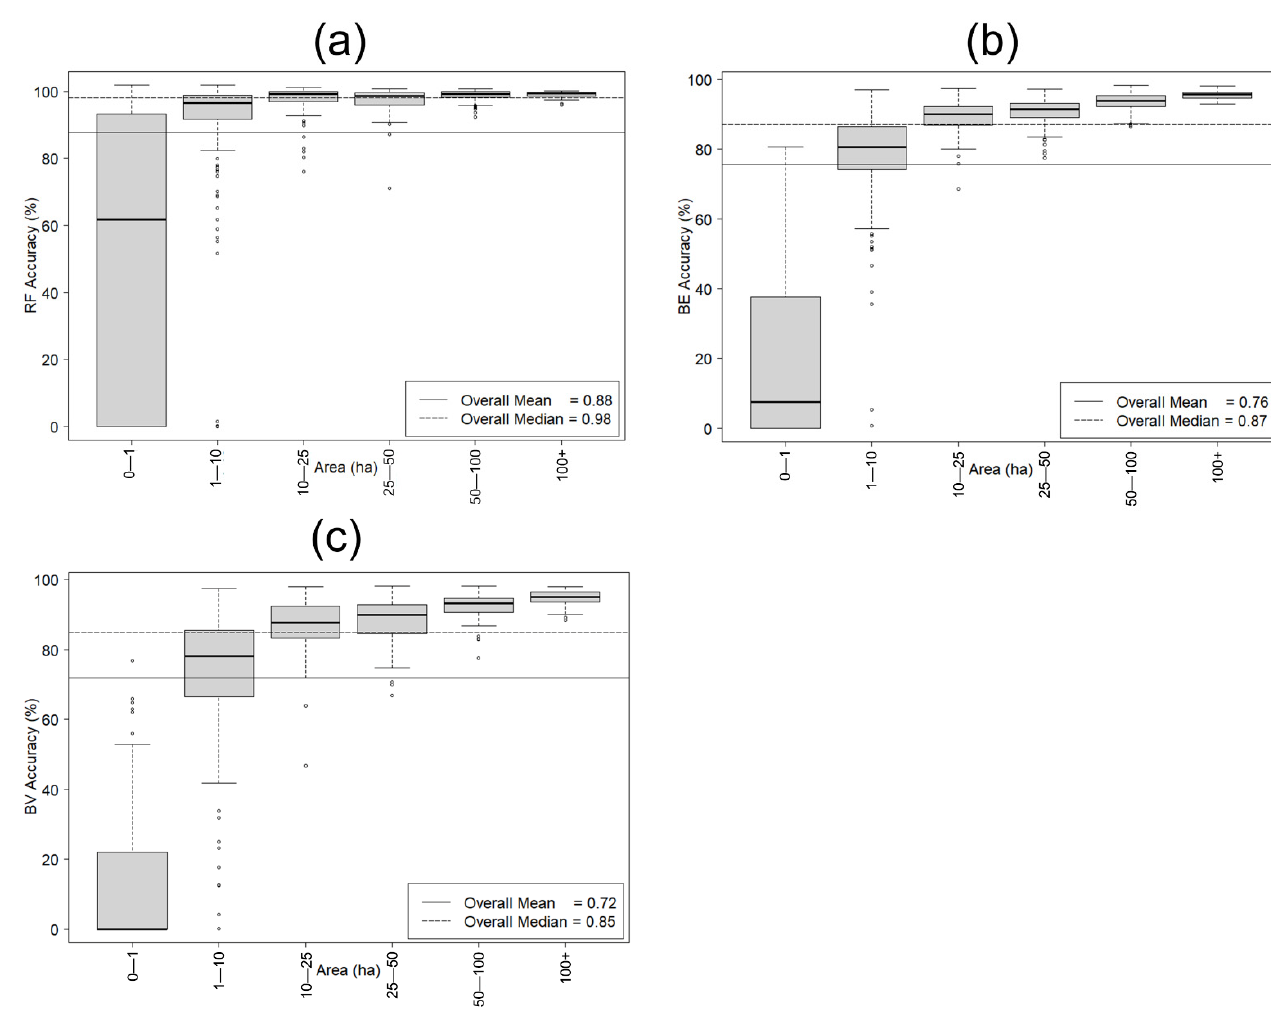
Figure 11. Comparative distribution of classifier accuracy with respect to waterbody area for all 517 waterbodies binned by size classes for ( a ) RF, ( b ) BE, and ( c )